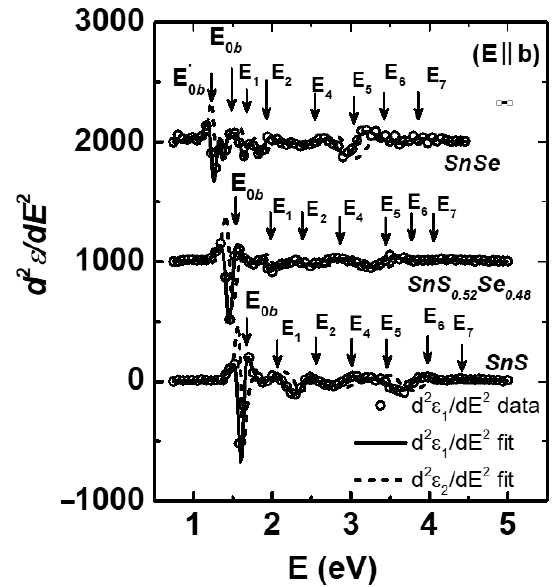
Figure 9. As Figure 8, for the armchair direction. The spectra are shifted by increments of 1000 from that at x = 1.